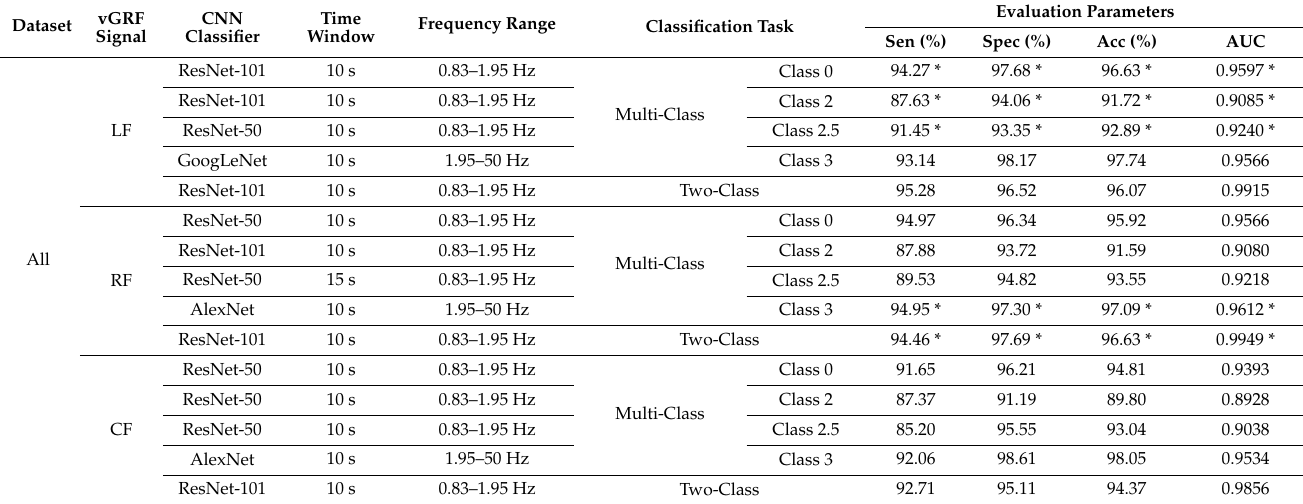
Table 23. Multi-class (CO (Class 0) vs. PD Stage 2 (Class 2) vs. PD Stage 2.5 (Class 2.5), and PD Stage 3 (Class 3)) and two-class classification (CO vs. PD (Class 2, Class 2.5, and Class 3)) Summary using several CNN classifiers (AlexNet, ResNet-50, ResNet-101, and GoogLeNet) with 10-fold cross-validation for all